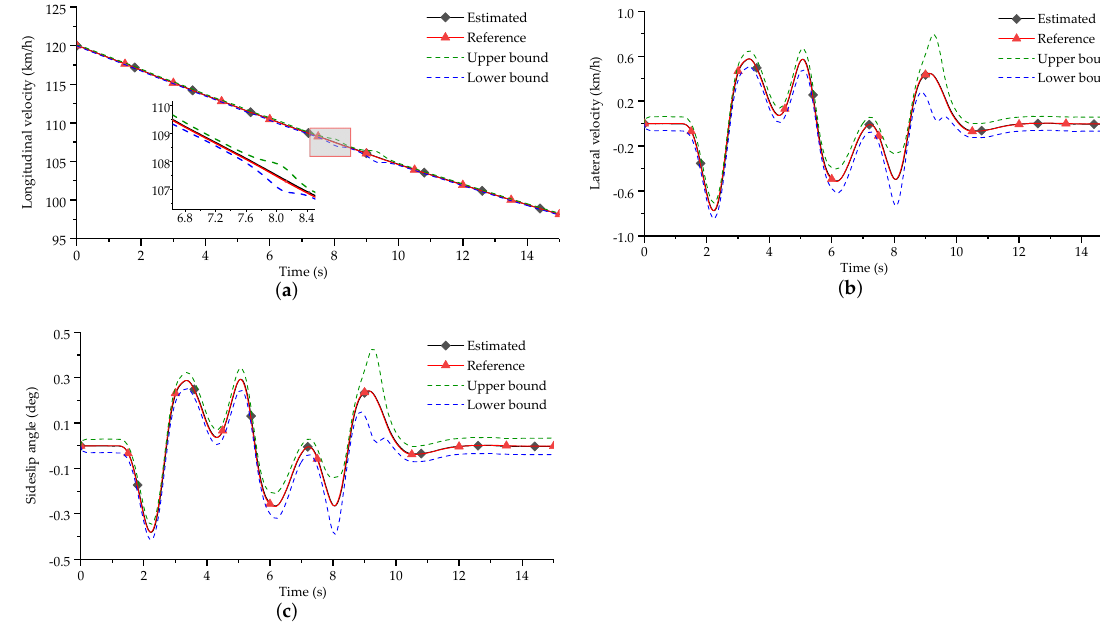
Figure 9. Results of the ESMF-based strategy under the DLC maneuver. ( a ) Longitudinal velocity; ( b ) Lateral velocity; ( c ) Vehicle sideslip